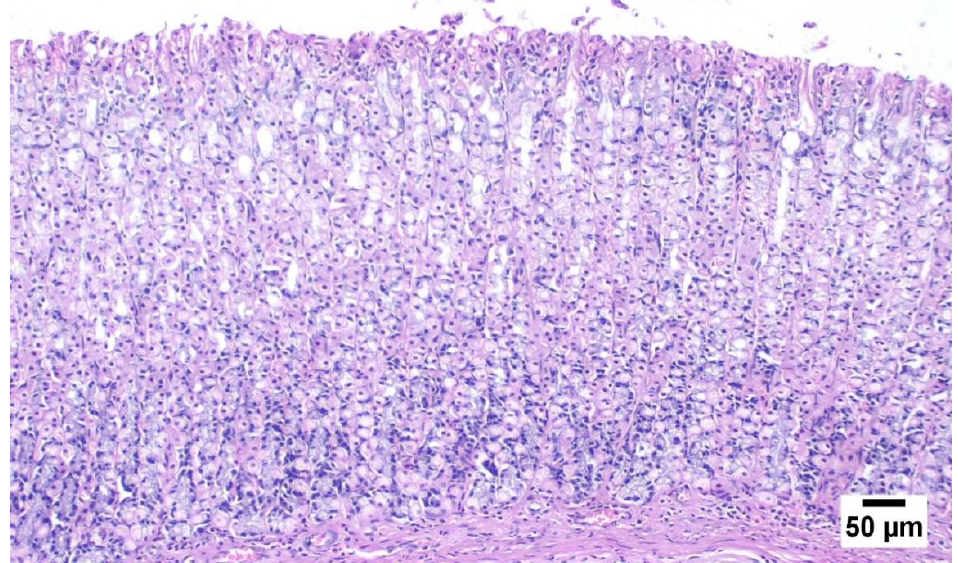
Figure 18. Photomicrograph of stomach, G4-D12-Asp showing apparently normal gastric mucosa (H&E).